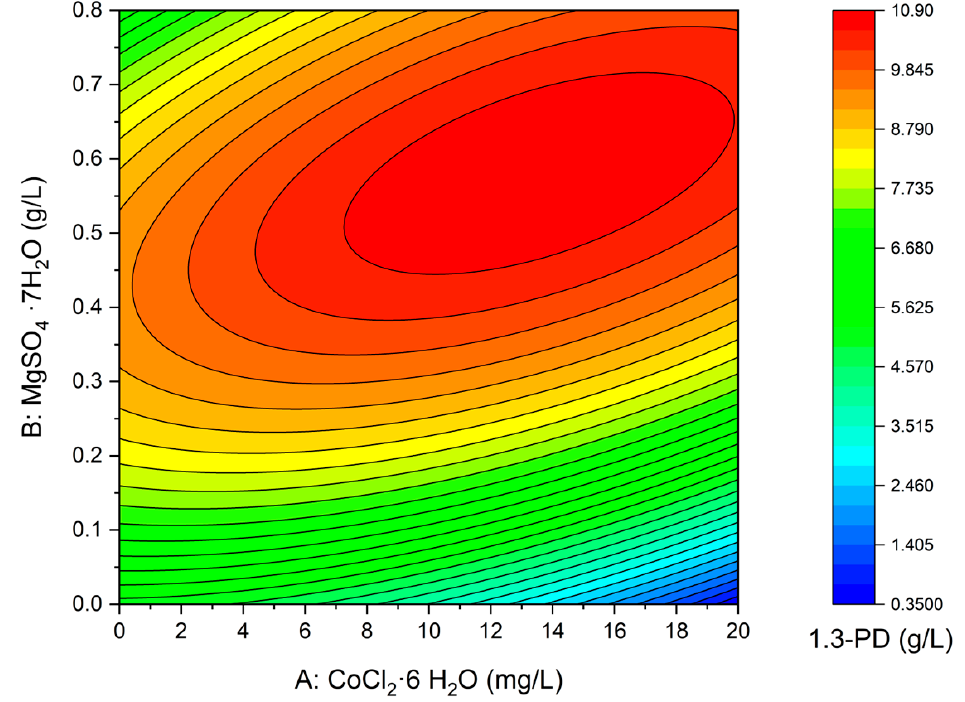
Figure 6. Response surface for the 1,3-PD production according to the central composite design.